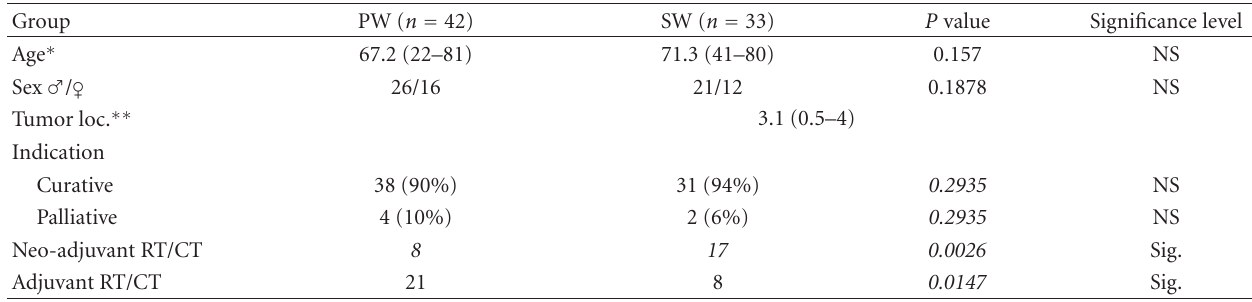
Table 1: Patients treated by APR for a low rectal cancer ( n = 75).